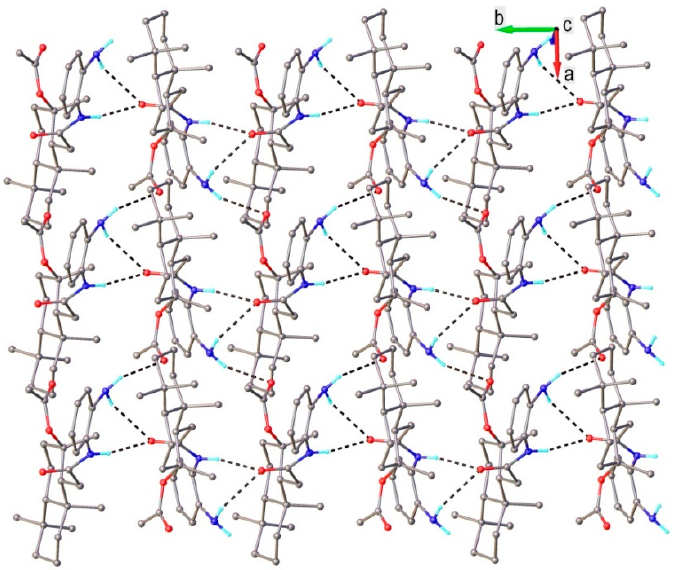
Figure 3. Intermolecular hydrogen bonding in crystal 20 showing the formation of a 2D supramo- lecular network. Hydrogen bonds parameters: N1-H ∙∙∙ O3 [N1-H 0.86 Å, H ∙∙∙ O3(1 − x , − 0.5 + y , 1 – z ) 2.05 Å, N1 ∙∙∙ O3 2.892(4) Å, ∠ N1HO3 164.6°]; N2-H ∙∙∙ O3 [N2-H 0.87 Å, H ∙∙∙ O3( − x , − 0.5 + y , 1 – z ) 2.46 Å, N2 ∙∙∙ O3 3.17(5) Å, ∠ N2HO3 128.8°]; N2-H ∙∙∙ O2 [N2-H 0.88 Å, H ∙∙∙ O2( − x , − 0.5 + y , 1 – z ) 2.52 Å,